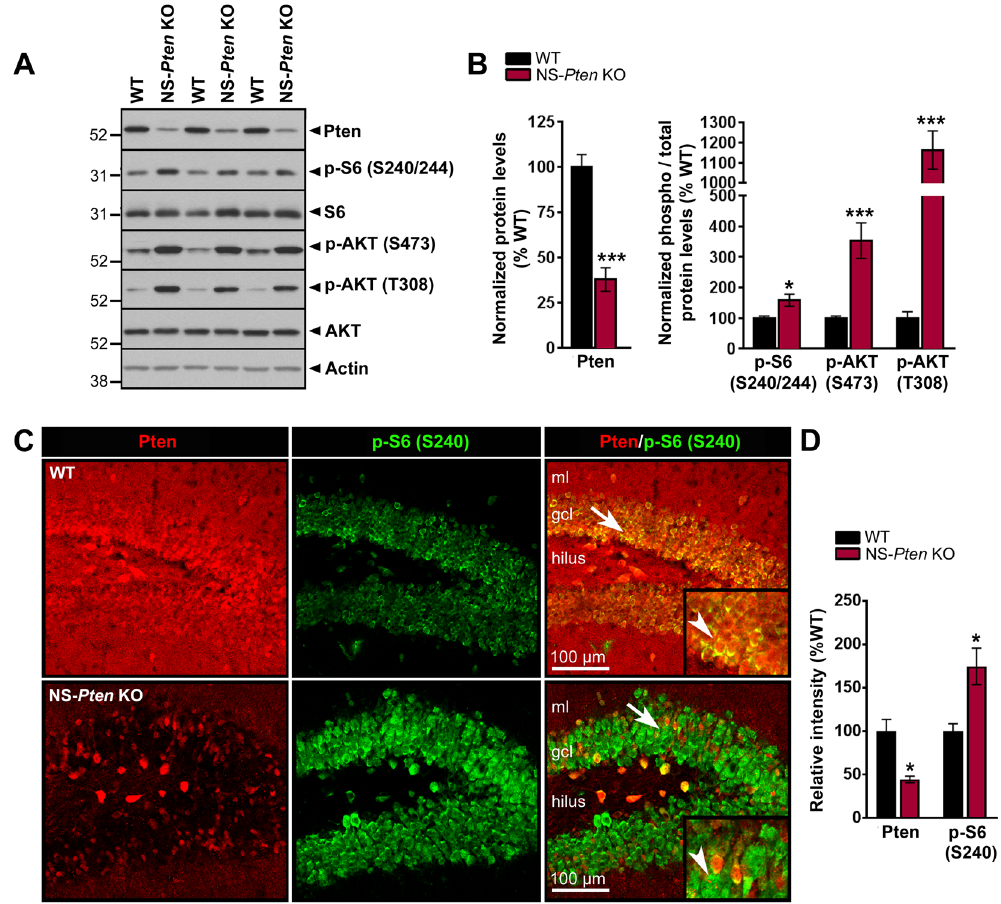
Figure 1. PI3K-Akt-mTOR signaling is hyperactivated in the hippocampus of NS- Pten KO mice. ( A ) Representative western blots from whole hippocampal homogenates from 6 week-old WT and NS- Pten KO mice probed with antibodies against Pten, p-S6 (S240/244; marker of mTORC1 activation), S6, p-AKT (S473; marker of mTORC2 activation), p-AKT (T308; marker of PI3K activation), AKT, and actin are shown. Full-length blots are presented in Supplemental Fig. 2. ( B ) Quantification of the western blots showed that Pten protein levels were significantly reduced while p-S6 (S240/244), p-AKT (S473), and p-AKT (T308) protein levels were significantly increased in NS- Pten KO compared to WT mice. n = 8 mice per group; * p < 0.05, *** p < 0.001 by Student’s t-test; errors bars are ± SEM. ( C ) Representative single optical sections of Pten and p-S6 (S240) co-immunostaining in 6 week-old WT and NS- Pten KO DG are shown. Arrows point to the areas that are enlarged in the insets. Arrowheads in the insets point to Pten-positive cells with basal p-S6 (S240) staining in WT DG and Pten-negative cells with elevated p-S6 (S240) staining in NS- Pten KO DG. ( D ) Quantification of Pten and p-S6 (S240) immunostaining intensity in the DG granule cell layer show significantly decreased Pten intensity and significantly increased p-S6 intensity in NS- Pten KO compared to WT mice. n = 3 mice per group. * p < 0.05 by Student’s t-test; errors bars are ± SEM. gcl, granule cell layer; ml, molecular layer